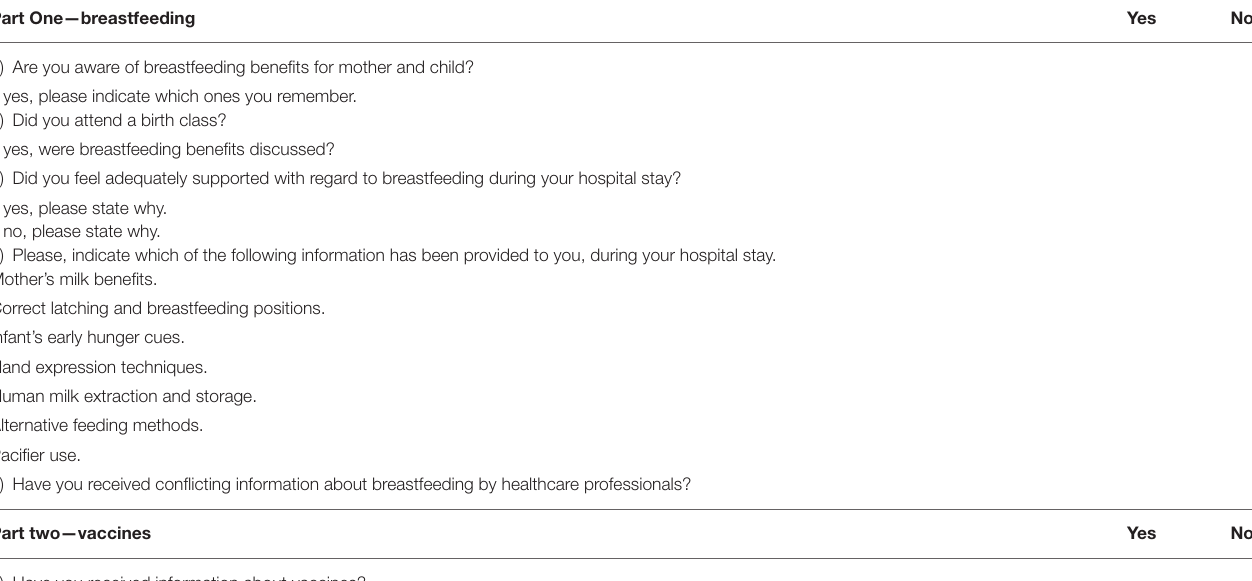
TABLE 1 | Questionnaires on breastfeeding and vaccines. Part One—breastfeeding